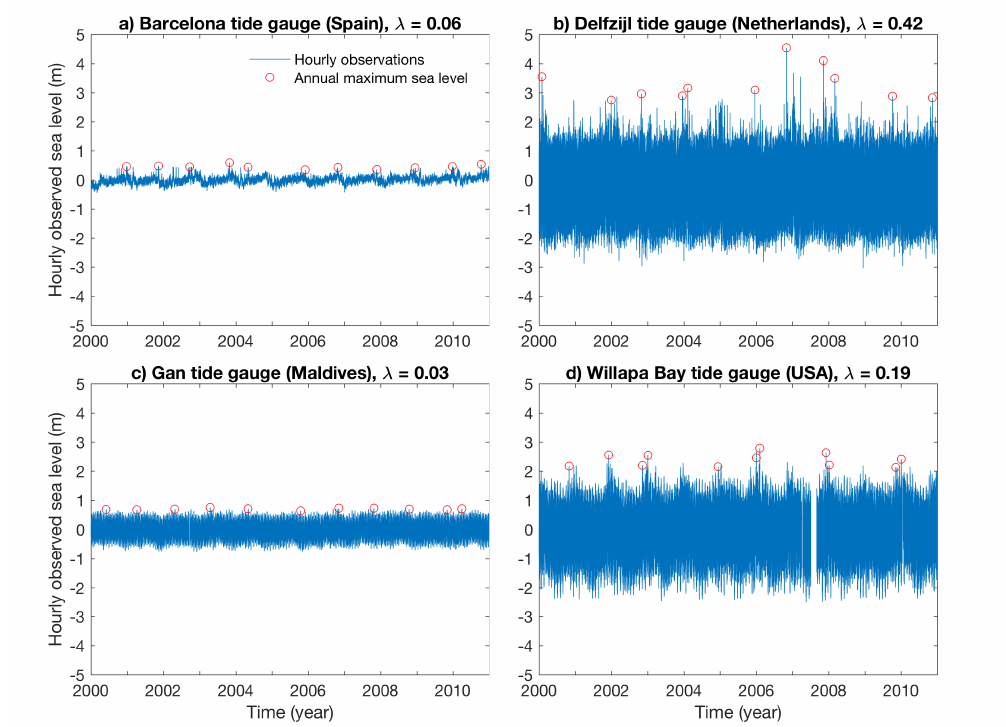
Figure 2. Four examples of tide gauge records: ( a ) Barcelona, ( b ) Delfzijl, ( c ) Gan, ( d ) Willapa Bay. Hourly data (in blue) and their annual maximum values (red) for 2000–2010 (m), where the mean of each time series has been removed. λ = the Gumbel scale parameter (m). Locations are indicated in Figure 5a by their first